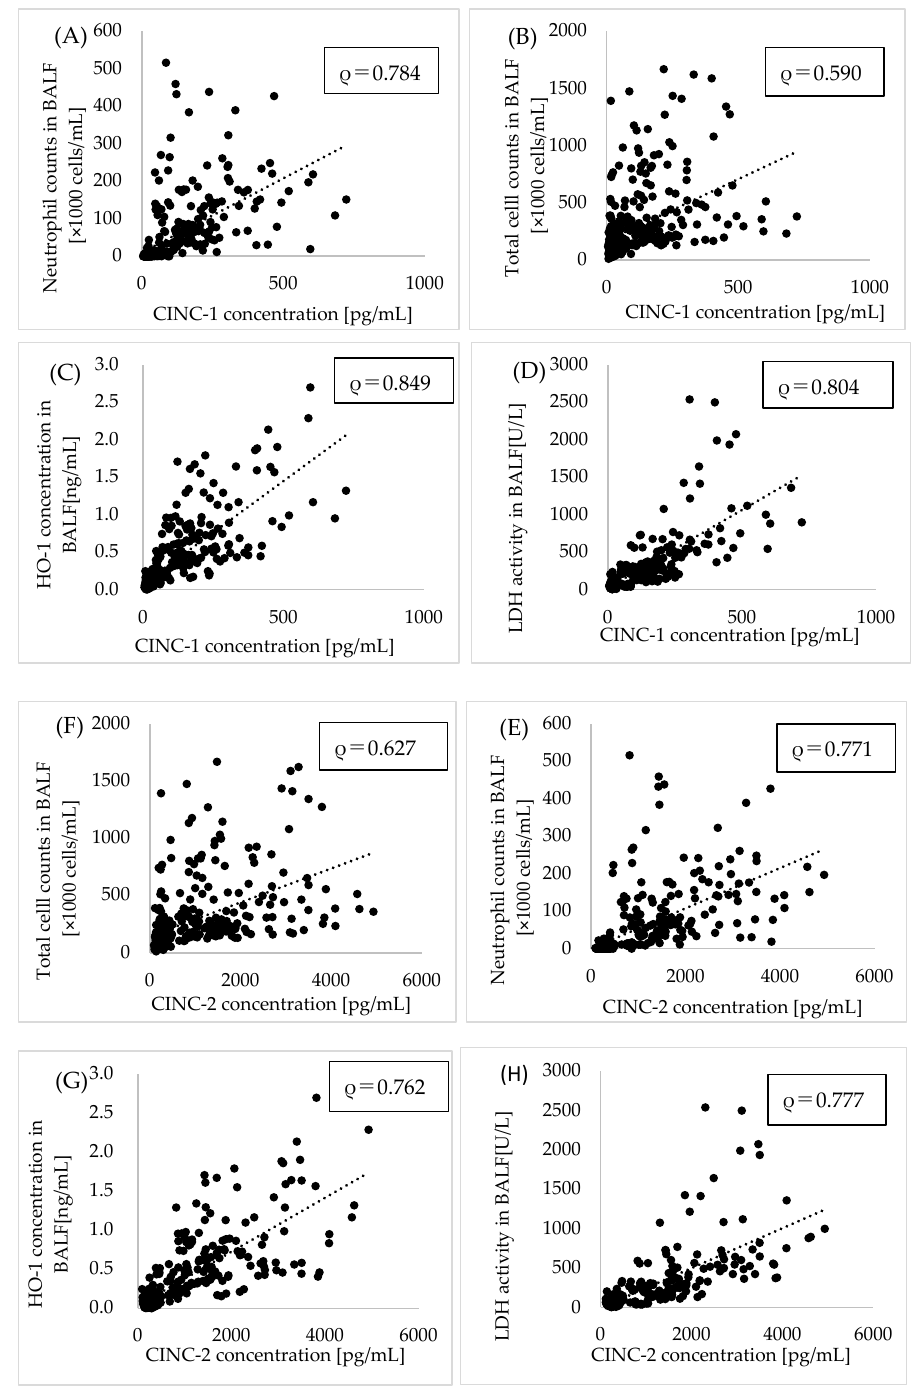
Figure4. RelationshipbetweenCINCsandinflammatory, oxidativestressorlunginjury. ( A )neutrophils, ( B ) total cell ( C ) rat heme oxygenase (HO)-1 and ( D ) lactate dehydrogenase (LDH) versus CINC-1 and ( E ) neutrophils, ( F ) total cell ( G ) HO-1 and ( H ) LDH versus CINC-2 in BALF after inhalation and intratracheal instillation of NMs. Values of ρ are Spearman’s rank correlation coe ffi cient for all the